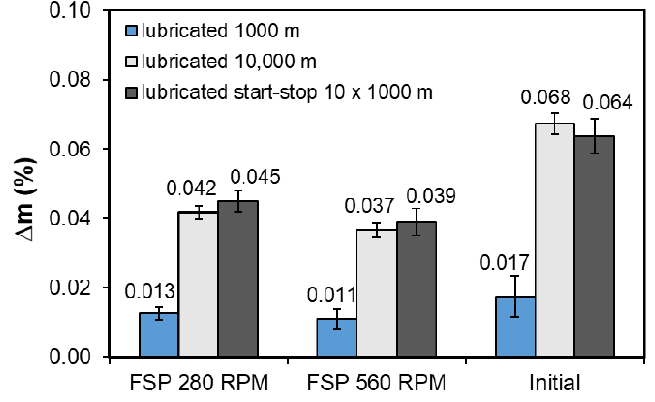
Figure 16. Weight loss determined at load of 50 N.